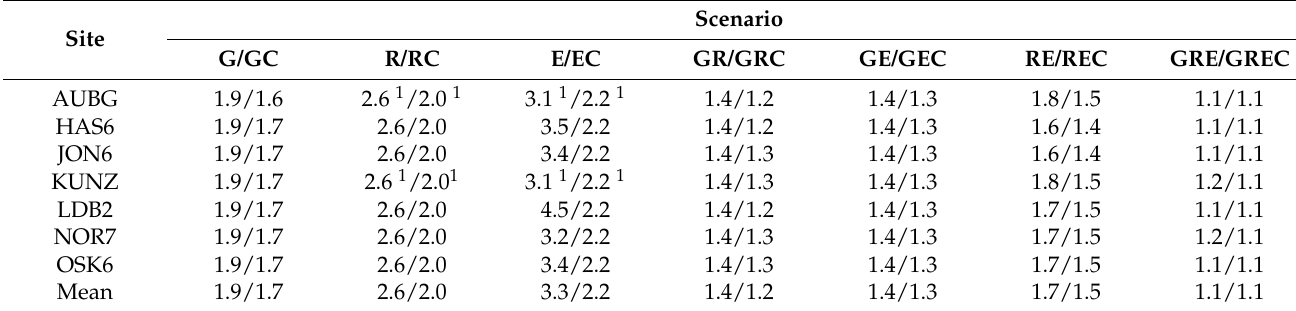
Table 5. Mean PDOP coefficient (1.01.2021).